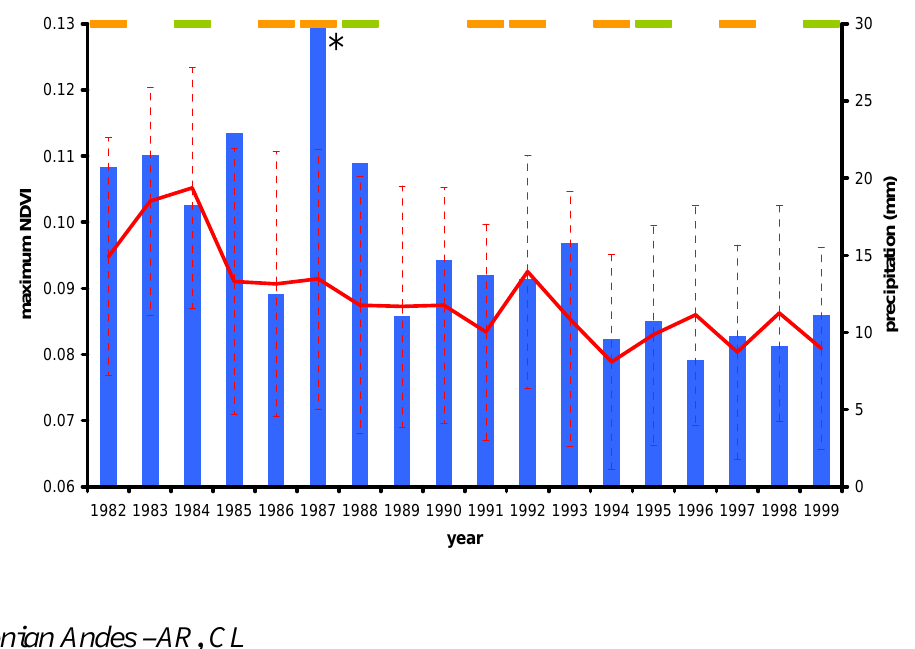
Figure 6. Northern Chilean deserts FASIR maximum annual NDVI during the 1982- 1999 period for 222 significant negative 8x8km pixels (red lines indicates the trend and vertical bars the standard deviations), annual accumulated precipitation (blue bars) for the approximate region delimited by the -22.25º to -24.25º latitude and -69.25º to - 70.75º longitude from the CRU TS 2.1 [118], and El Niño or La Niña years (orange and green upper horizontal bars, respectively), according to the “Multivariate ENSO Index” (MEI) [119] and “El Niño & La Niña Years: A Consensus List“ (http://ggweather.com/enso/years.htm). The correlation coefficient (r 2 ) between MEI and NDVI annual maximum values was 0.03 ( α =0.05). * for the year 1987 the precipitation was 86